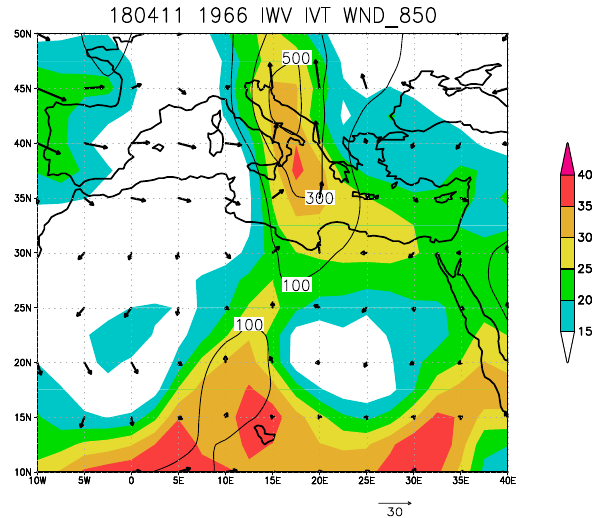
Figure 4. IWV (mm) starting from 15mm shaded IVT (kgm − 1 s − 1 ) and 850hPa winds (ms − 1 ) at 18:00UTC, 4 Novem- ber 1966; based on the data from the National Centers for Envi- ronmental Prediction (NCEP) – National Center for Atmospheric Research (NCAR) reanalysis project (NNRP) (Kalnay et al.,